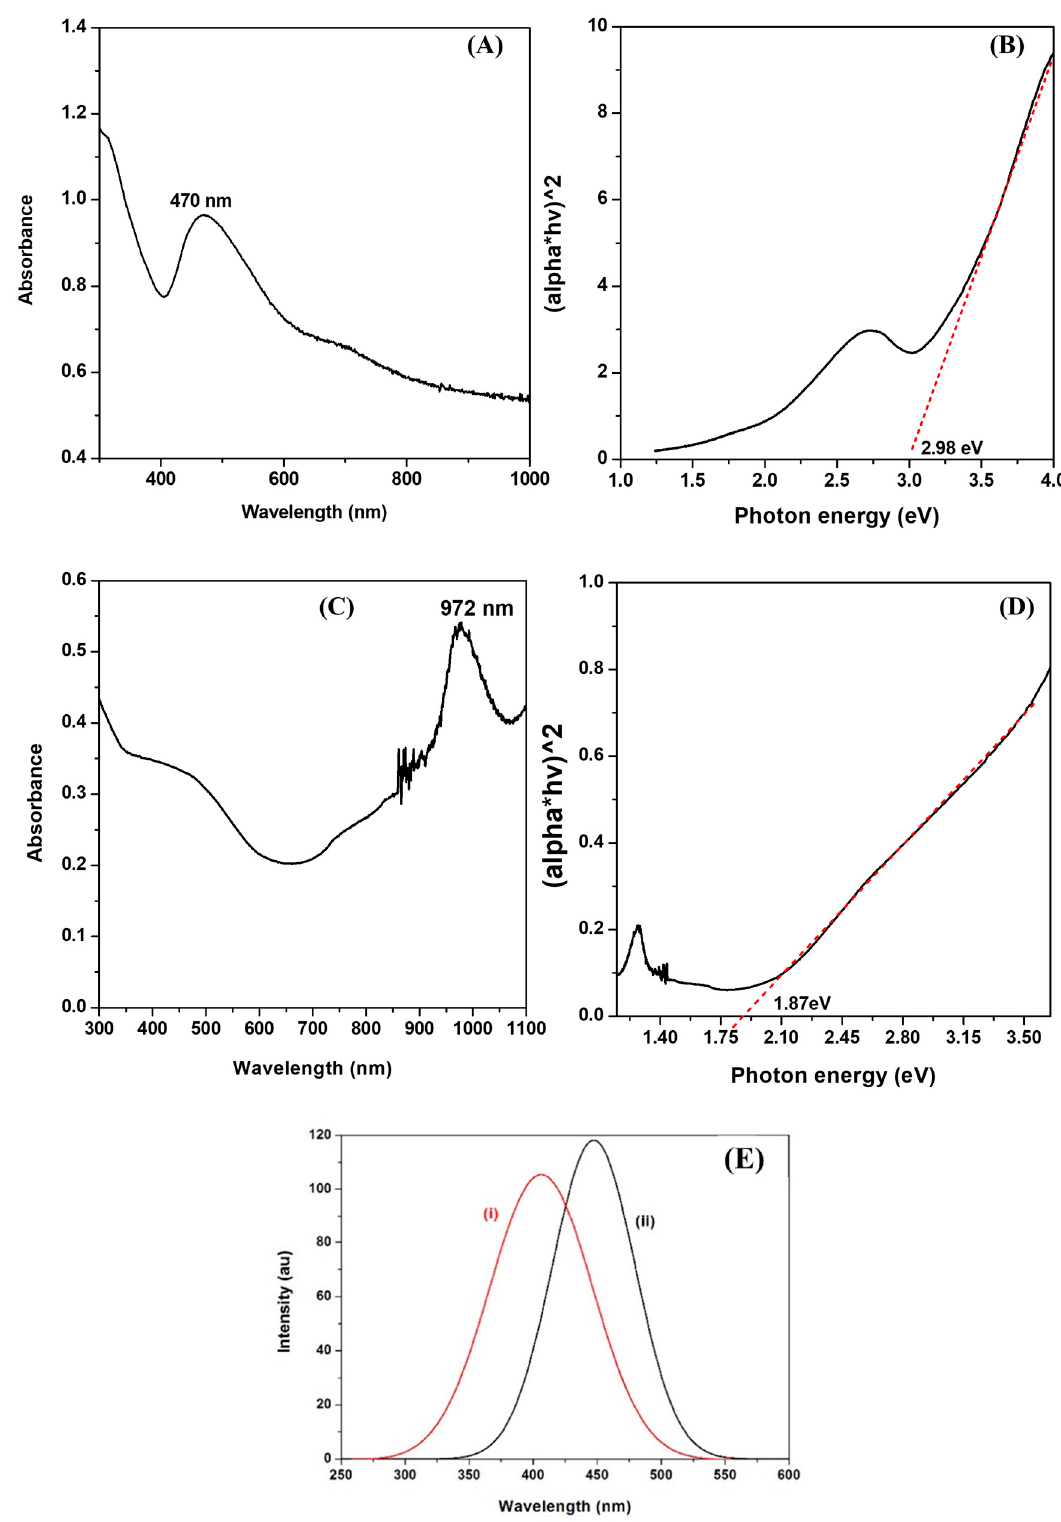
Figure 2. Absorption spectra and Tauc Plots of GSH-capped CuS-1 ( A , B ) and CuS-2 ( C , D ), respec- tively. ( E ) Photoluminescence spectra of (i) CuS-1 and (ii) CuS-2.